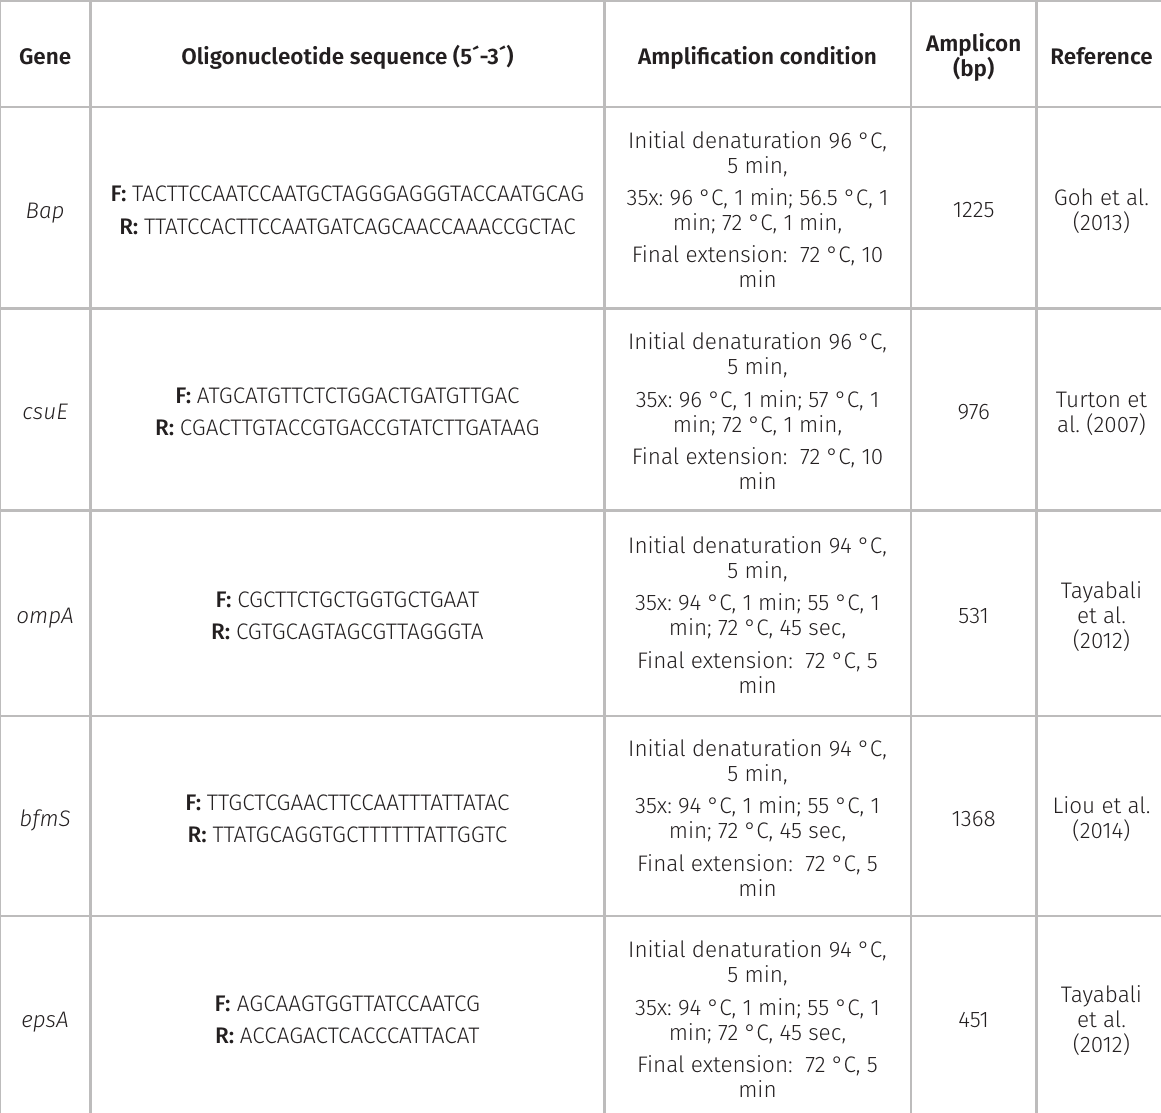
Table I. List of primers and amplification conditions for the search of virulence genes in Acinetobacter spp.